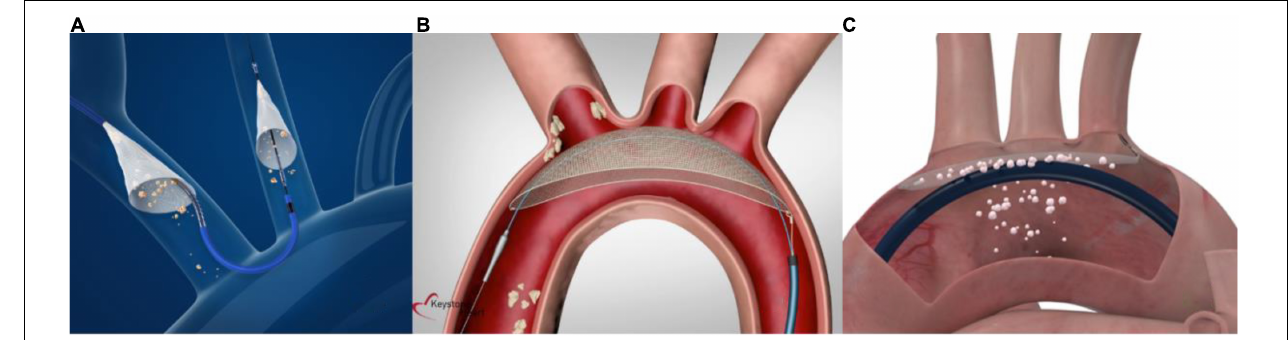
FIGURE 4 | Current cerebral embolic protection devices. (A) The Sentinel device is a dual- filter-based intra-luminal embolic protection device introduced via the right radial, ulnar, or brachial artery. A proximal filter is placed in the brachiocephalic trunk and a distal filter in the left carotid artery (material provided courtesy of Boston Scientific.© 2022 Boston Scientific Corporation or its affiliates. All rights reserved). (B) The TriGuard3 device is advanced to the aortic arch via the contralateral femoral artery and accommodates a diagnostic pigtail catheter. It covers all three supraaortic vessels to deflect embolic material (material provided courtesy of Keystone Heart, Ltd. All rights reserved). (C) The ProtEmbo device is delivered via the left radial arteria and deployed at the aortic arch roof to cover all three supraaortic vessels and deflect embolic material (material provided courtesy of Protembis GmbH. All rights reserved).